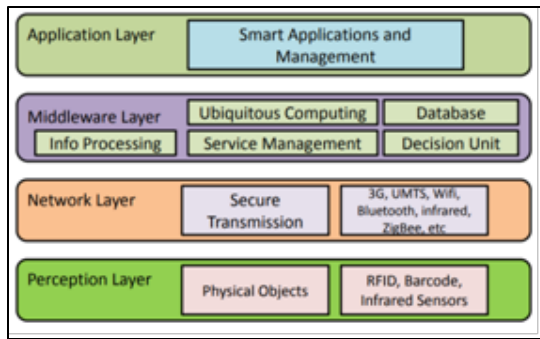
Figure 1: IoT Generic Architecture (as illustrated in